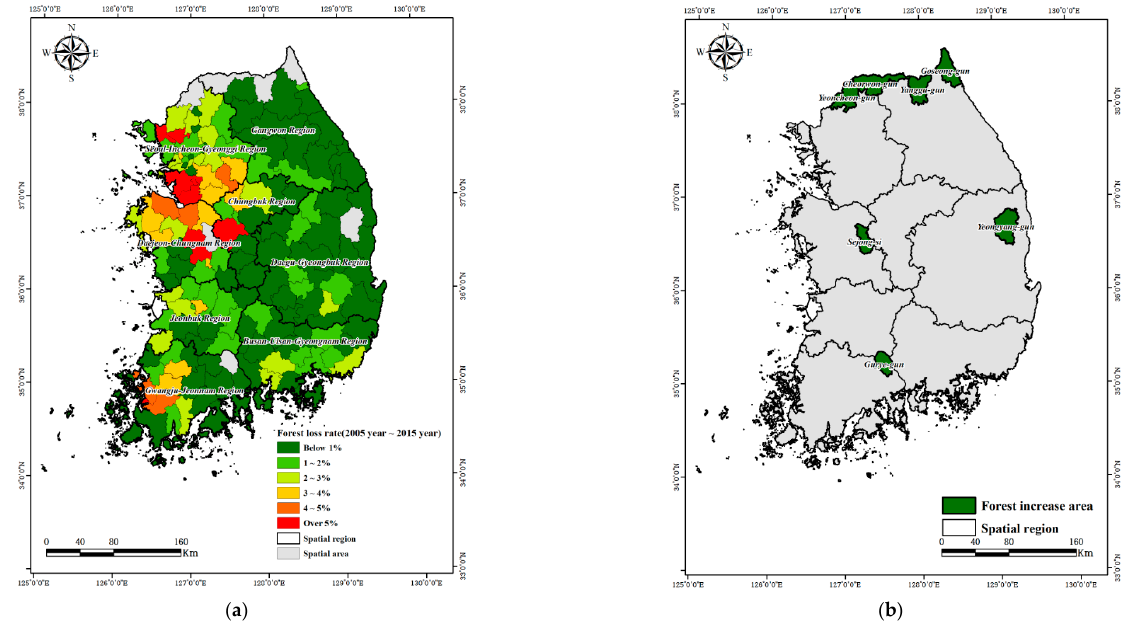
Figure 5. Forest loss area and forest increase area by spatial region and spatial area: ( a ) forest loss areas per spatial region and area; ( b ) forest increase areas per spatial region and area. Table 5. Distribution of forest loss rate across spatial regions.